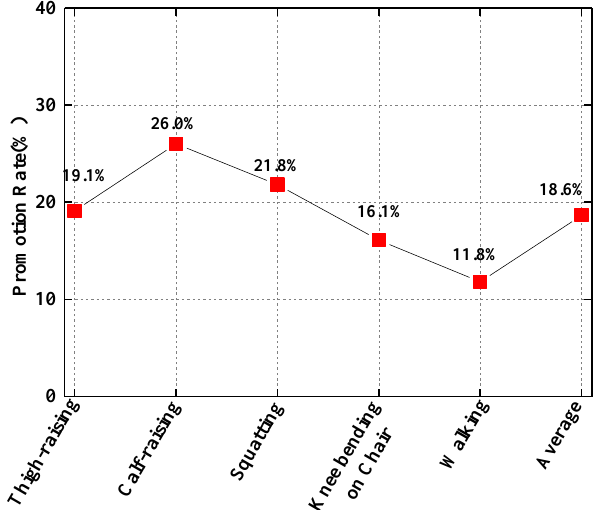
Figure 10. Improvement effect of BP_AdaBoost.